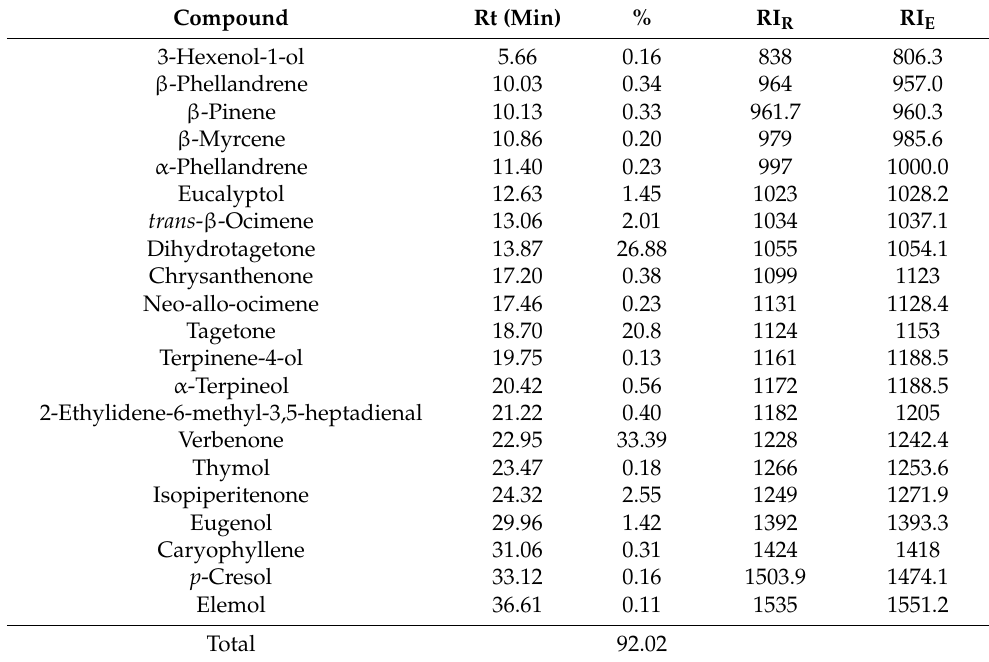
Table 1. The chemical composition of